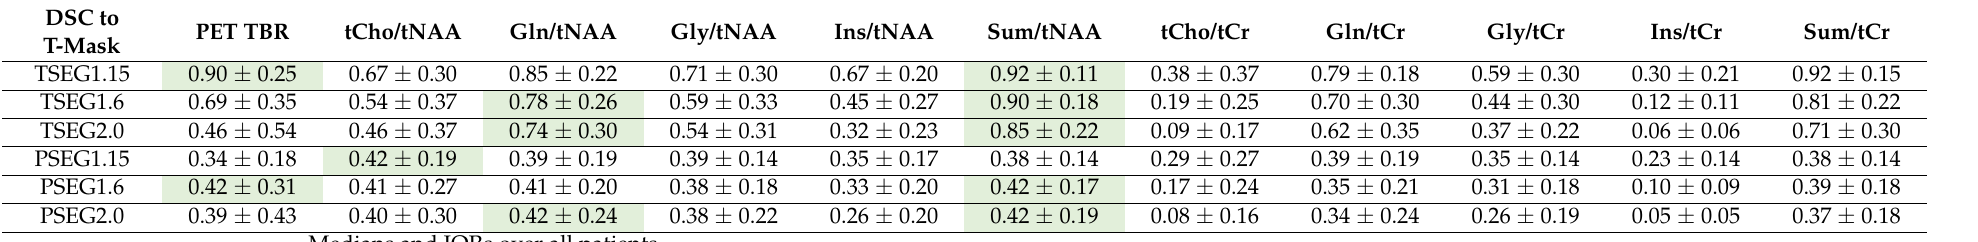
Table 3. DSCs to the T-Segmentation over all ratios and VOI thresholds.